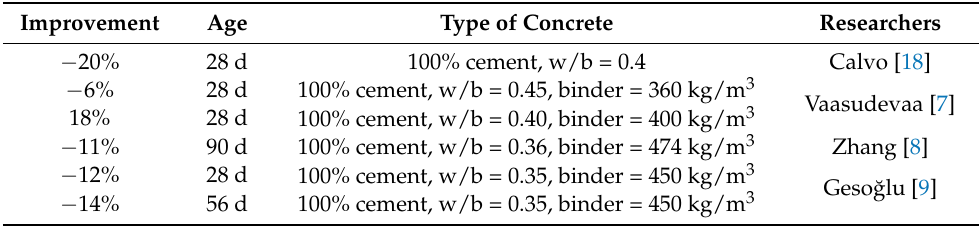
Figure 2. The effect of steam curing on the microstructure of concrete [16]. Table 2. Improvement in the later compressive strength of steam-cured concrete compared with standard-cured concrete.